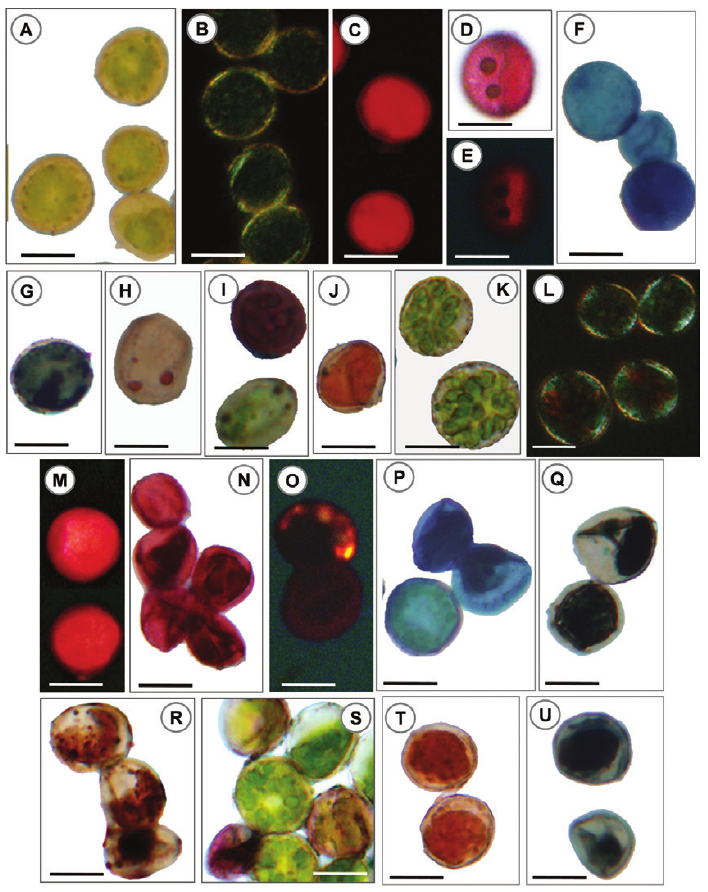
Figure 2 - A-U . Histochemical characterization of Pyrrhobryum spiniforme spores. A - J . Highland spores. K - U . Lowland spores. A - C, K - M . Fresh spores. A, D, F - K, N, P - U . under white light. B, L . polarized light. C, E, M, O . UV light. D, E, N, O . Staining with Neutral Red. F, P . Staining with Nile Blue. G, Q . Staining with Sudan Black B. H, R . Staining with Sudan IV. I, S . Staining with Ruthenium Red. J, T . Staining with Xylidine Ponceau. U . Staining with Aniline Blue Black. Scale Bar: 15